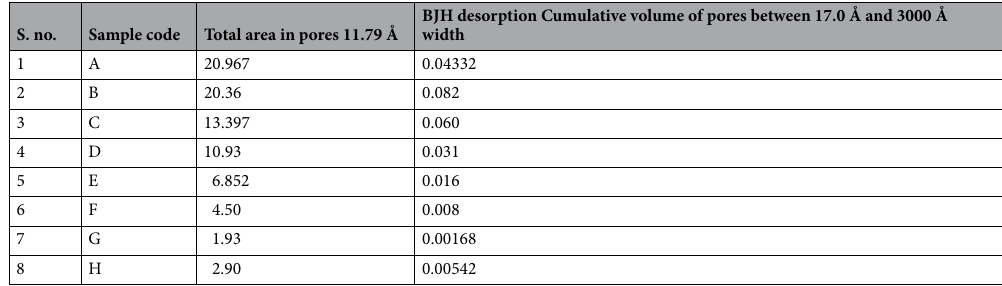
Table 5. Surface area analyzer study of MB sample (A–H) for the determination of open pore at one end having a dimension between 17–3000 Å and total area in pore 11.79 Å.